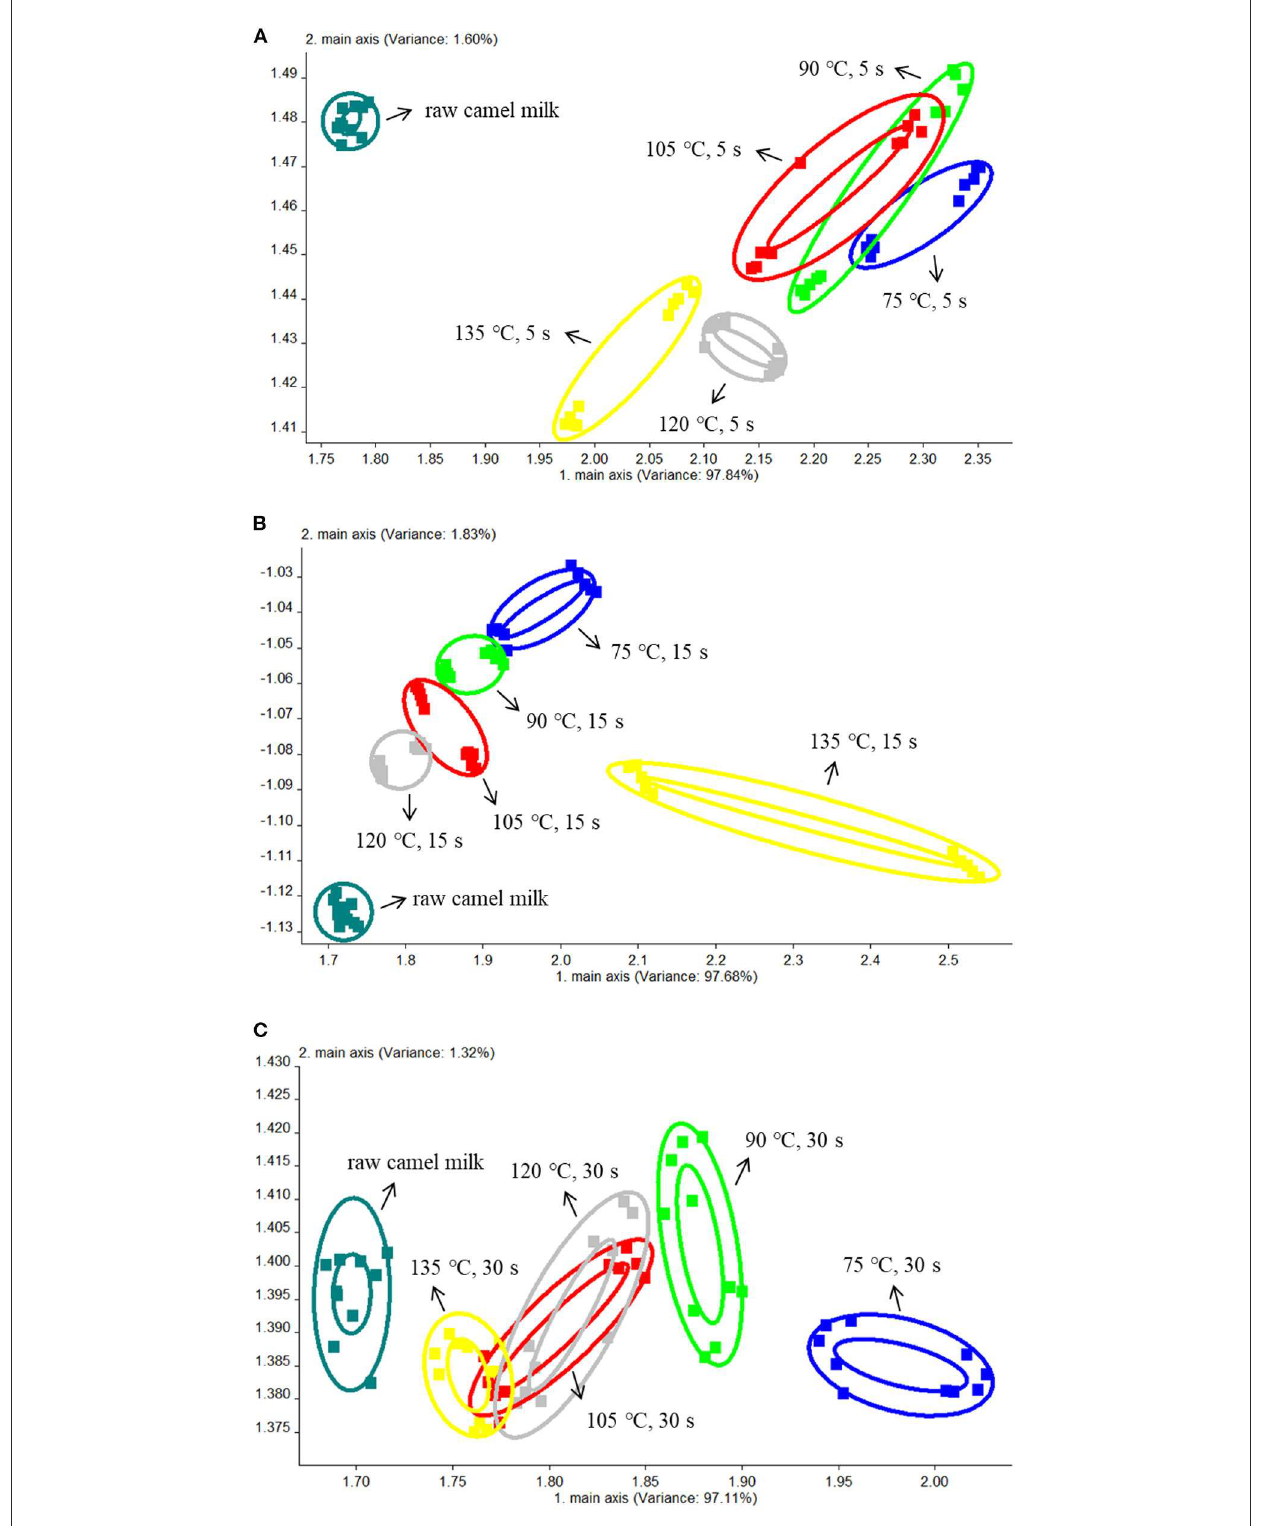
FIGURE1 The PCA results of the electronic nose data from camel milk samples heated at different temperatures for 5s (A) , 15s (B) , and 30 s (C) .